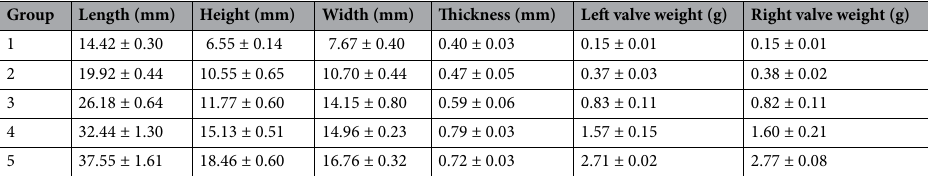
Table 1. Mean value and the standard error of the mean (±SEM): length, height, width, the thickness of the right shell, left valve weight, right valve